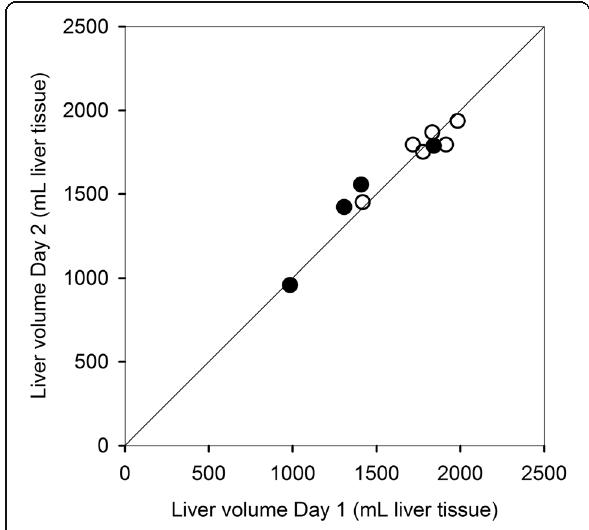
Fig. 3 Paired measurements of total functional liver volume in patients with cirrhosis (black circle) and healthy subjects (white circle) with line of identity